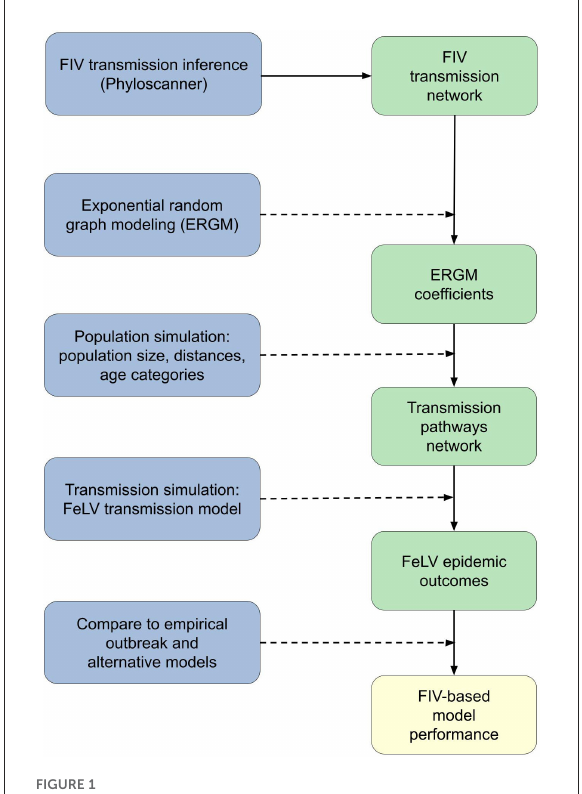
FIGURE1 Conceptual workflow across all analysis steps. Processes are shown on the left in blue; specific outcomes are shown on the right in green; the final analysis outcome is in yellow at the bottom right. Solid lines show direct flows or outcomes. Dashed lines show processes acting on or in concert with prior outcomes: for example, exponential random graph modeling (ERGM) was performed using the FIV transmission network, and the combination of the two produced the ERGM coefficients